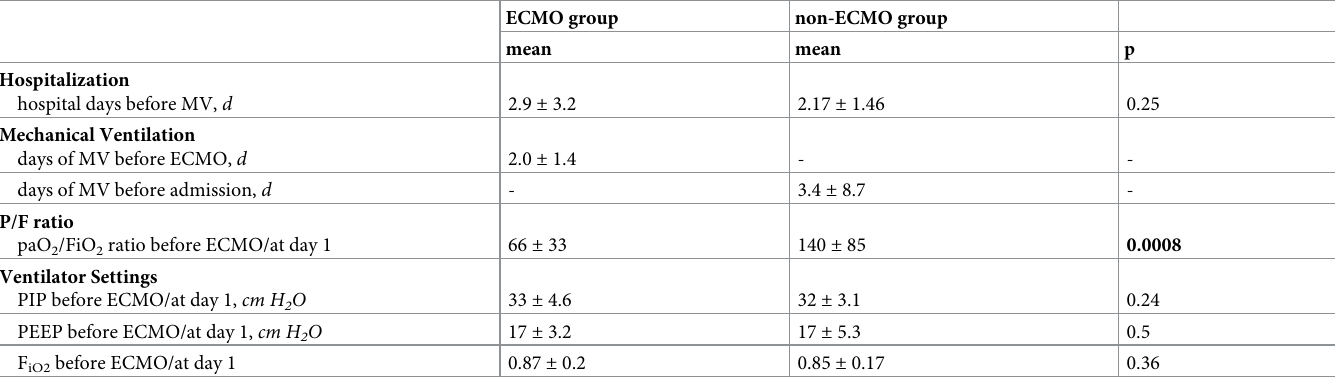
Table 2. Clinical parameters before initiating ECMO in regards to hospitalization, mechanical ventilation, P/F ratio and ventilator